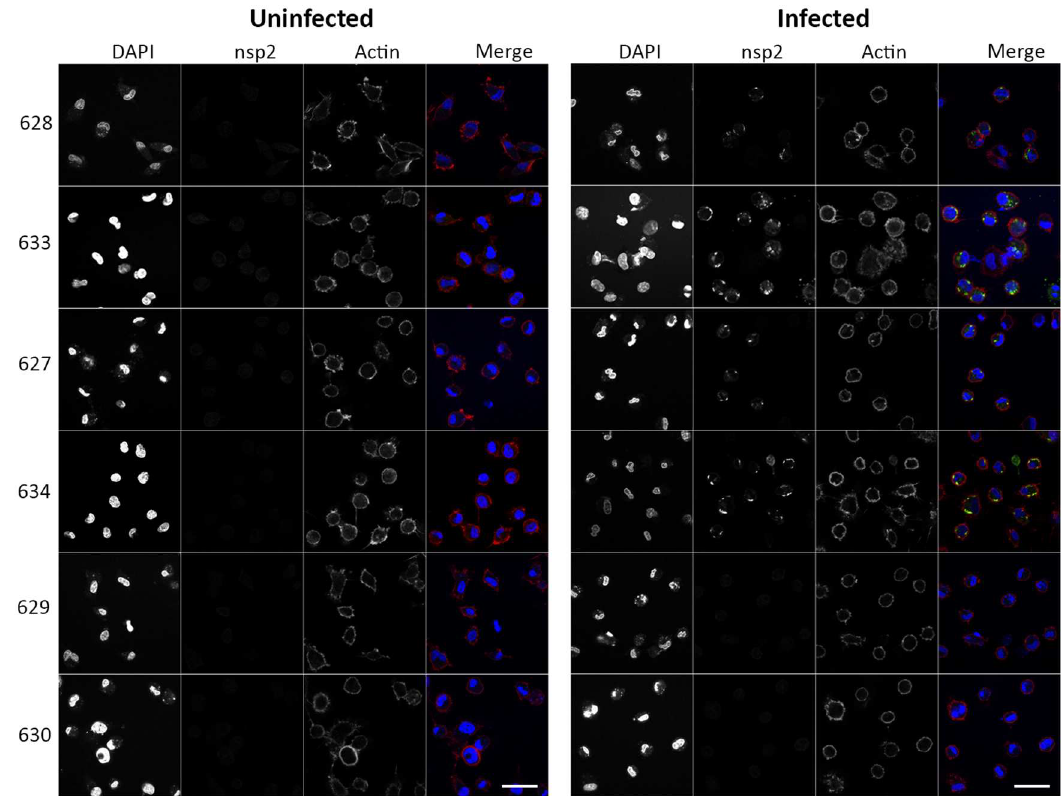
Fig 7. PRRSV infection of Δ SRCR5pulmonary alveolar macrophages (PAMs) is halted prior to the formation of the replication/transcription complex. PAMs from wild type (top two panels),heterozygous (middle two panels), and Δ SRCR5(bottom two panels)animalswere inoculated at MOI = 2 with PRRSV genotype1, subtype 3 (strain SU1-Bel). 22 hpi cells were fixed and stainedwith an anti PRRSV-nsp2 antibody, DAPI, and phalloidin.Scale bar represents 40 μ